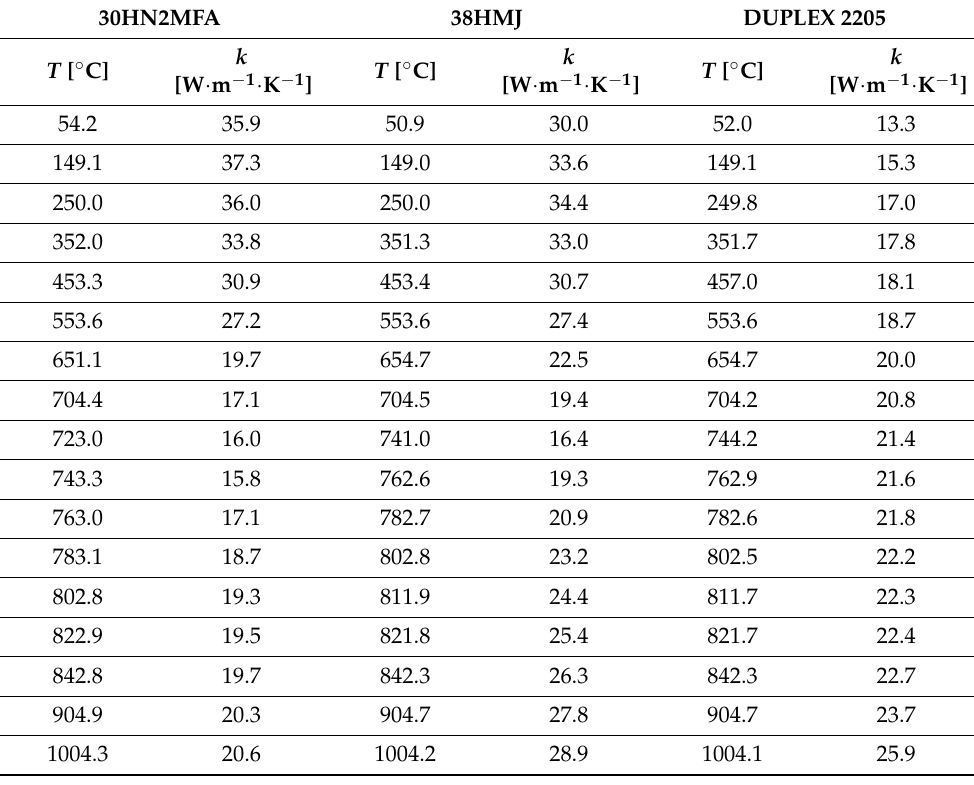
Table 2. Data on thermal conductivity of selected barrel steels [12].